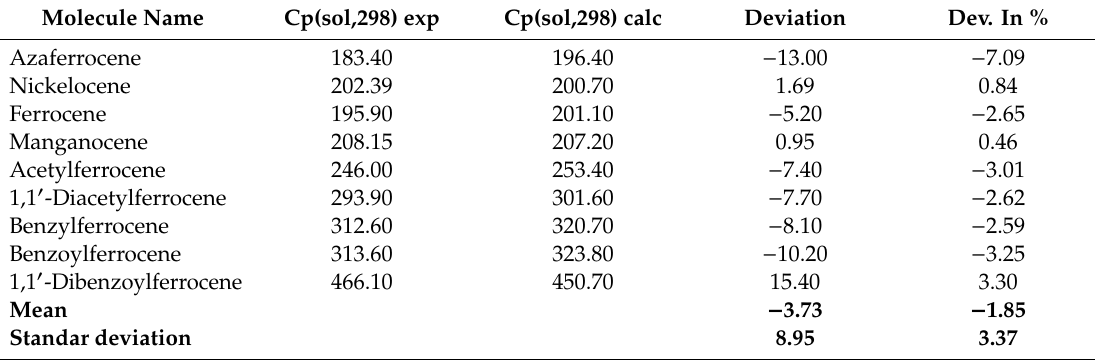
Table 11. Experimental and Equation (5)-calculated Cp(sol.298) of 9 metallocenes in J / mol / K.